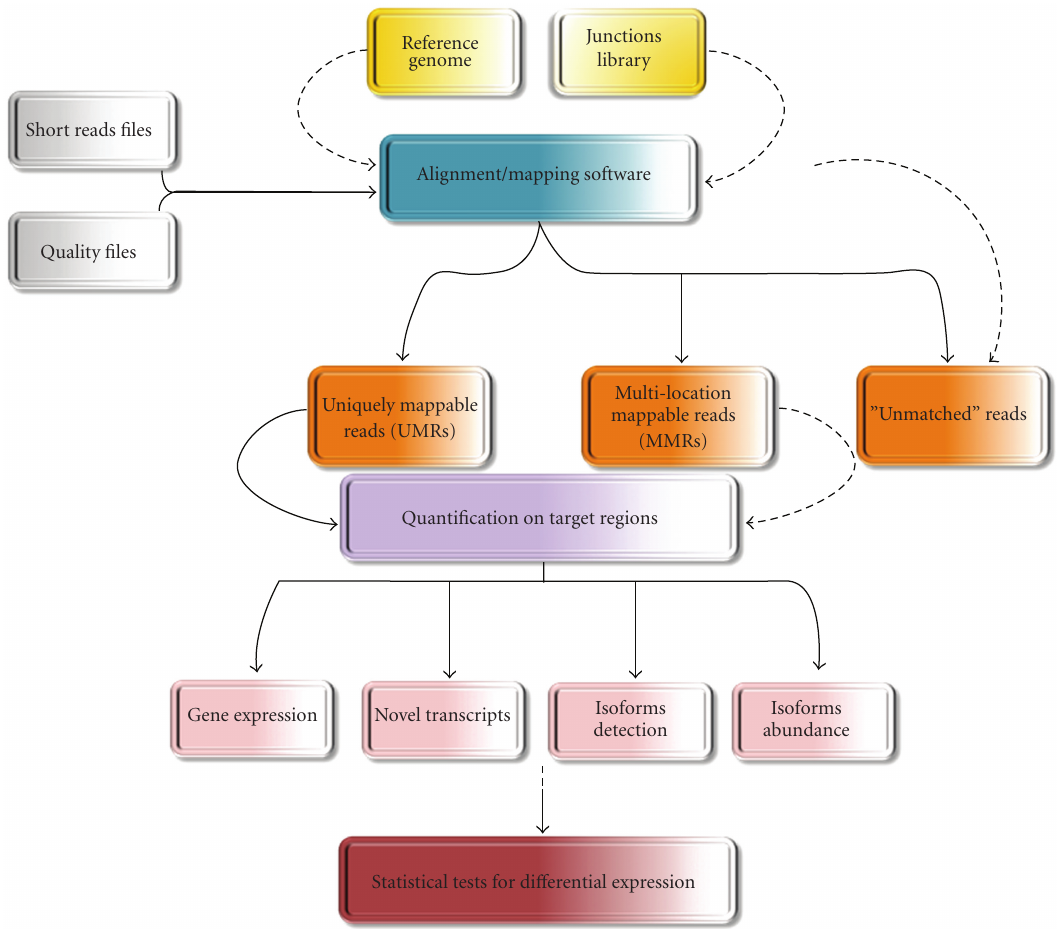
Figure 3: RNA-Seq computational